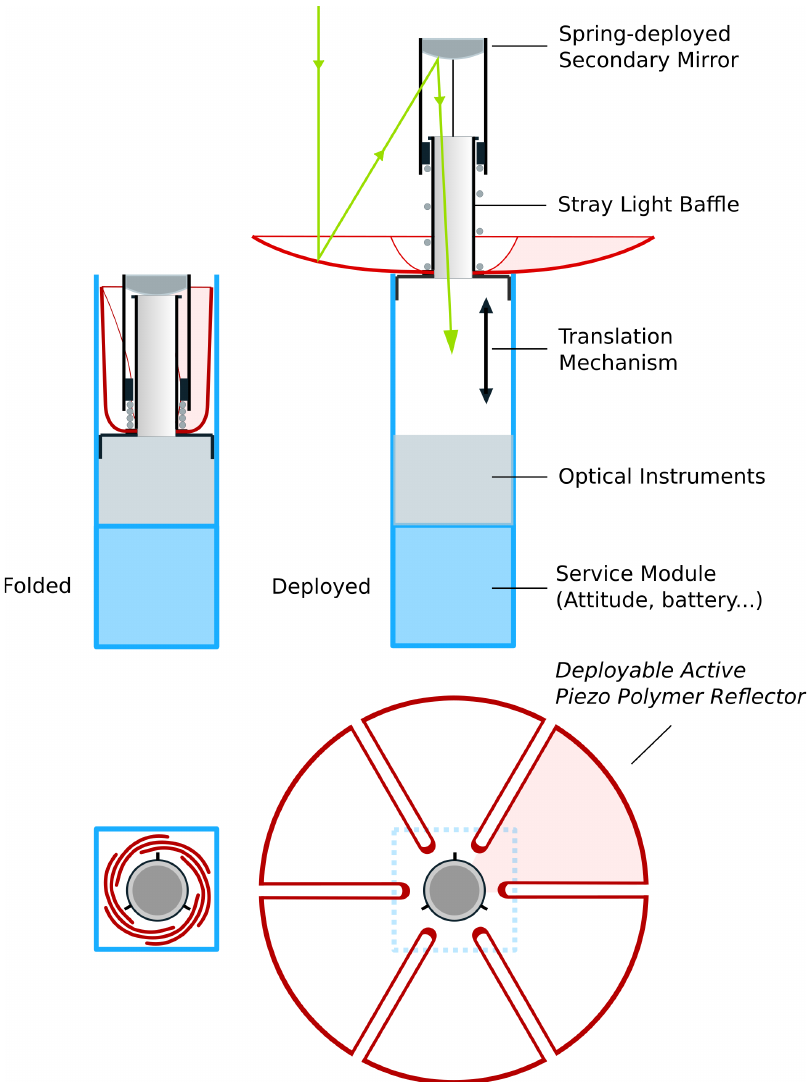
Figure 1. Deployable reflector made of 6 petals folded in a 3U cubesat ( left ) and deployed ( right ) thanks to a translation